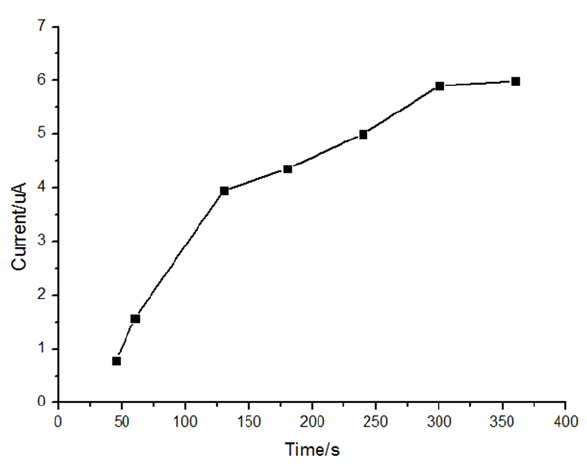
Figure 5. Variation of peak current with adsorption